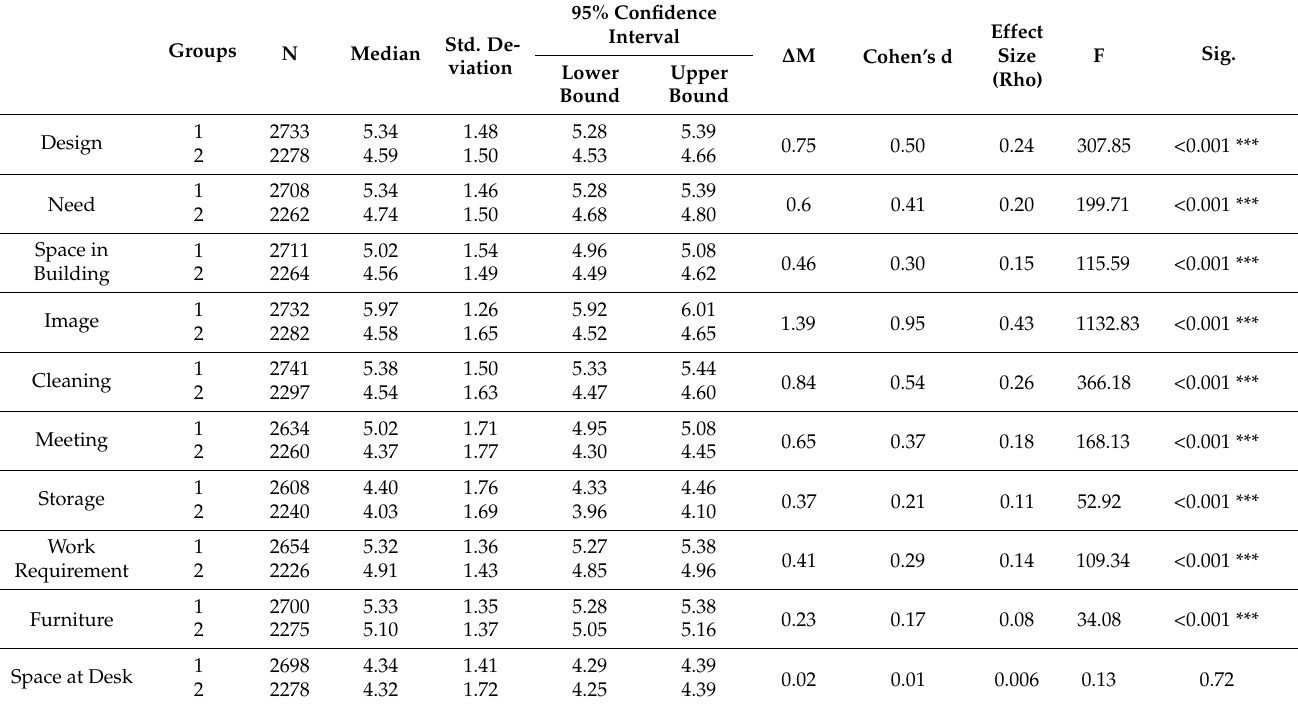
Table 5. Mean differences and effect size calculation comparing green and non-certified buildings regarding operational